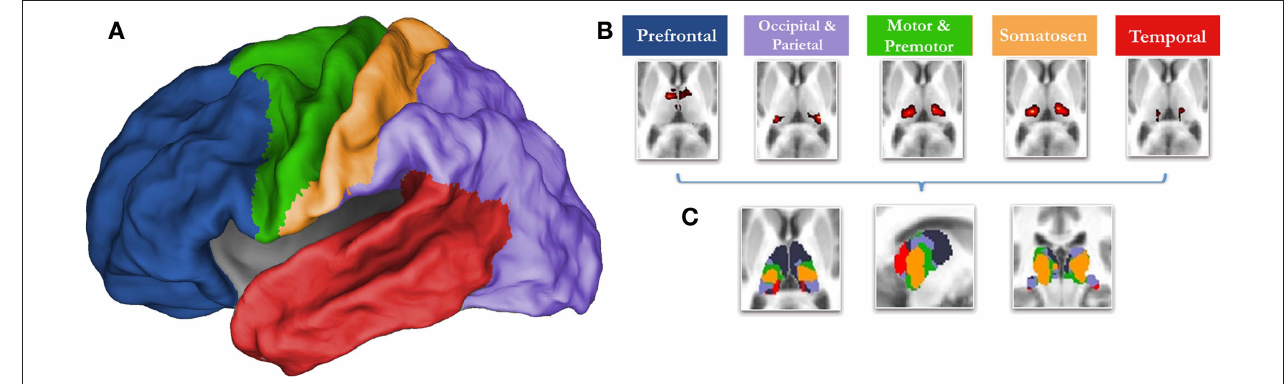
FIguRe  | The ‘winner take all’ strategy for identifying subdivisions of the thalamus (Zhang et al., 008), utilizes known thalamocortical topographic segregation (Alexander and Crutcher, 990; Jones, 007) to identify functional boundaries in the thalamus. (A) Regions of interest (ROIs) used for the current analysis. These regions are composed of five disjoint cortical subdivisions, which include the prefrontal cortex (blue), motor/premotor (green), somatosensory (yellow), parietal/occipical cortex (purple), and temporal corex (red). (B) The average spontaneous signal generated from each cortical ROI is then correlated with all of